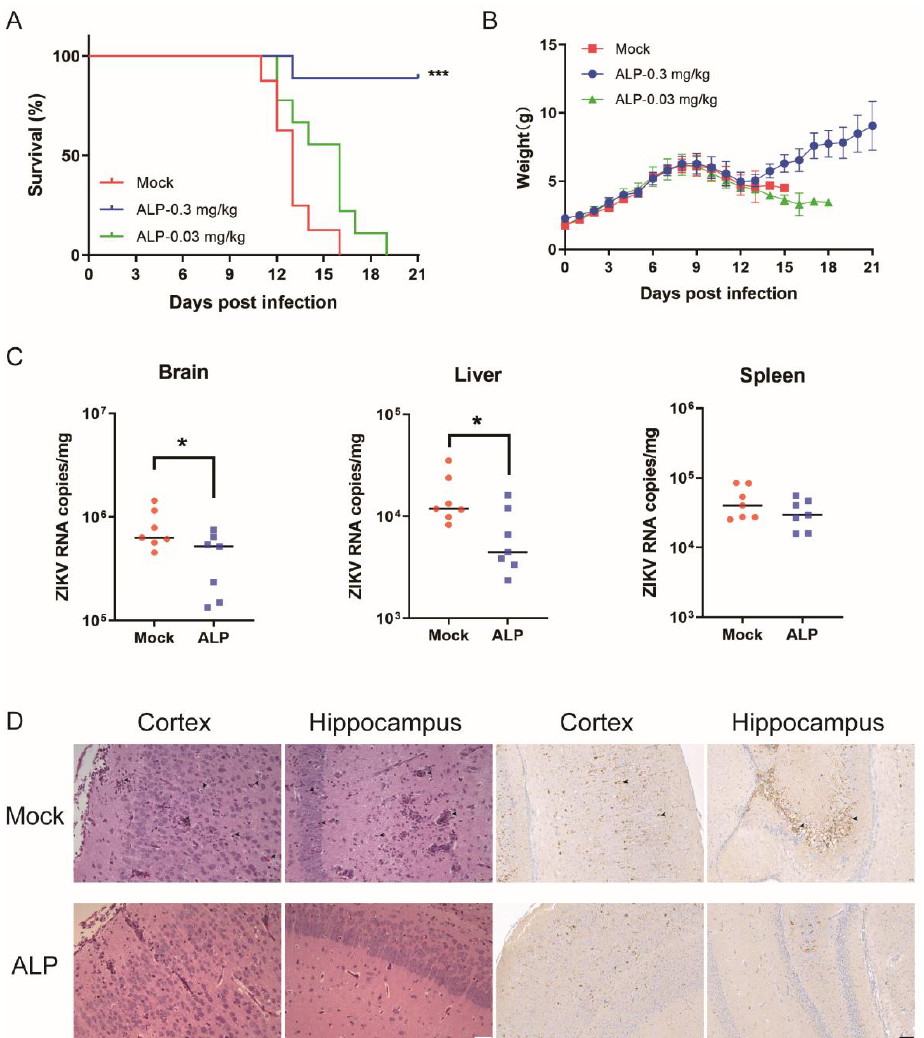
Figure 5. In vivo anti-ZIKV efficacy of ALP in the ZIKV lethal challenge mouse model. One-day-old ICR suckling mice were treated with 0.3 mg/kg or 0.03 mg/kg of ALP intraperitoneally (i.p.) 4 h after ZIKV-SMGC-1 challenge (1.2 × 10 4 PFU/mouse, i.p.), and this was administered for 9 consecutive days. The changes in survival ( A ) and bodyweight ( B ) of the ZIKV-infected mice in each group were recorded until 21 d.p.i.. Survival data were analyzed using a log-rank test, *** p < 0.001. ( C ) The viral loads in mouse brains, livers, and spleens were measured by qRT-PCR. * p < 0.1. ( D ) H&E staining (scale bar = 50 µm) and immunohistochemistry assay (scale bar = 200 µm) of sectioned brains. At 3 days post-infection, azelnidipine treatment alleviated the histopathological changes in mice caused by ZIKV infection. The viral antigens were visualized using NS2B antibodies via an immunohistochemistry assay. Yellow staining is considered to show viral